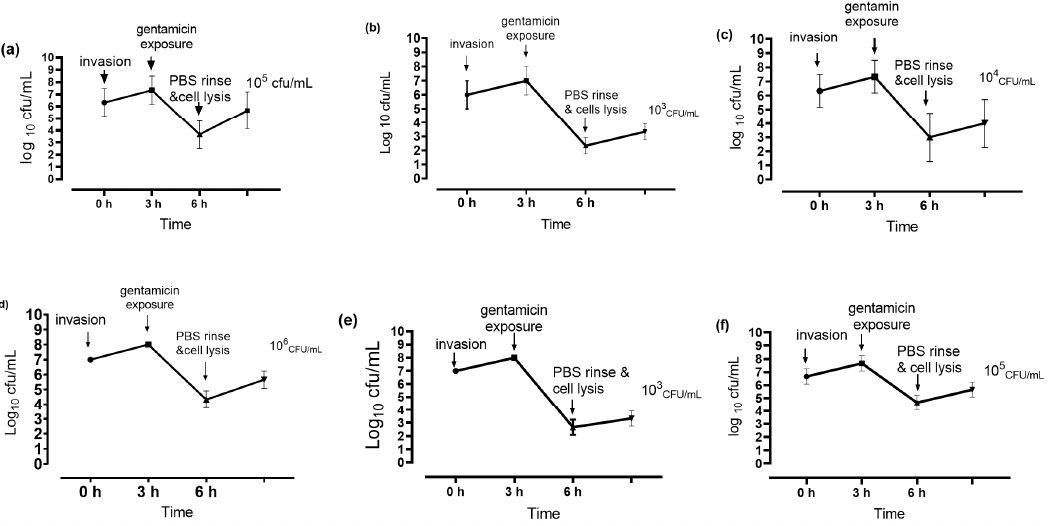
Figure 3. S. aureus invasion of MAC-T cells. Each graph ( a – f ) shows the survival of invasive isolates of S. aureus in MAC-T cells. Lysis of MAC-T cells after gentamicin exposure released approximately 10 6 CFU/mL of S. aureus F41B (d), 10 5 CFU/mL of F41A (a) and PBF1 (f), 10 4 CFU/mL of F31D (d), and 10 3 CFU/mL of F53D (e), and F51B(b). The graphs were generated using GraphPad Prism 8